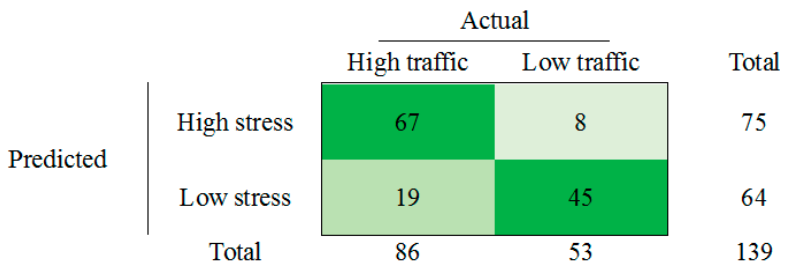
Figure 6. Confusion matrix of the model using the traffic condition datasets.